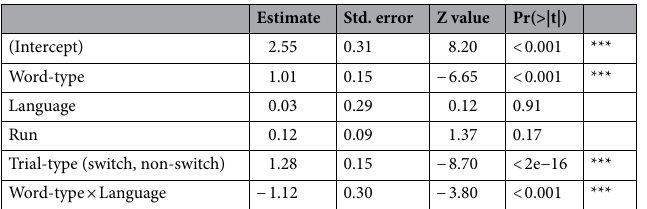
Table 1. Results from the generalized linear mixed effect model predicting accuracy. Asterisks indicate main effects that reached